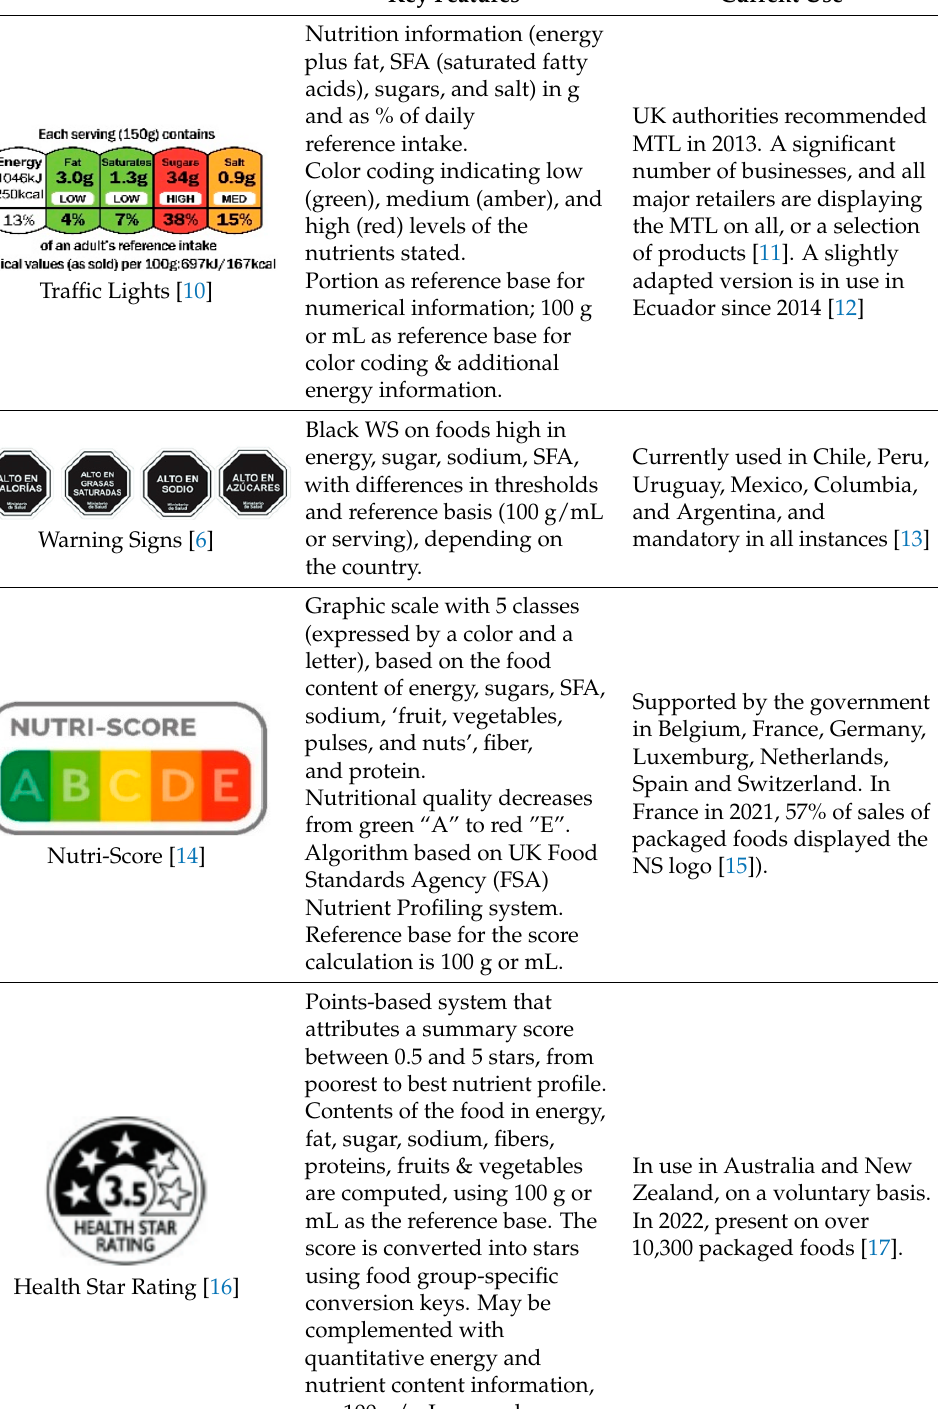
Table 1. Key features and information on the current use of the four selected FOPNLs.